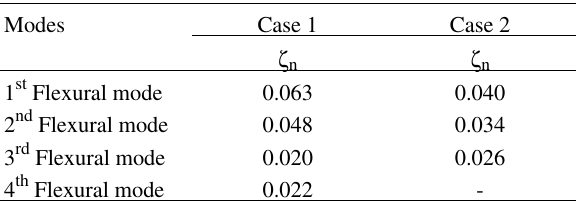
Table 3. Damping factors from experimental results, calculated by pro- gram FREQ